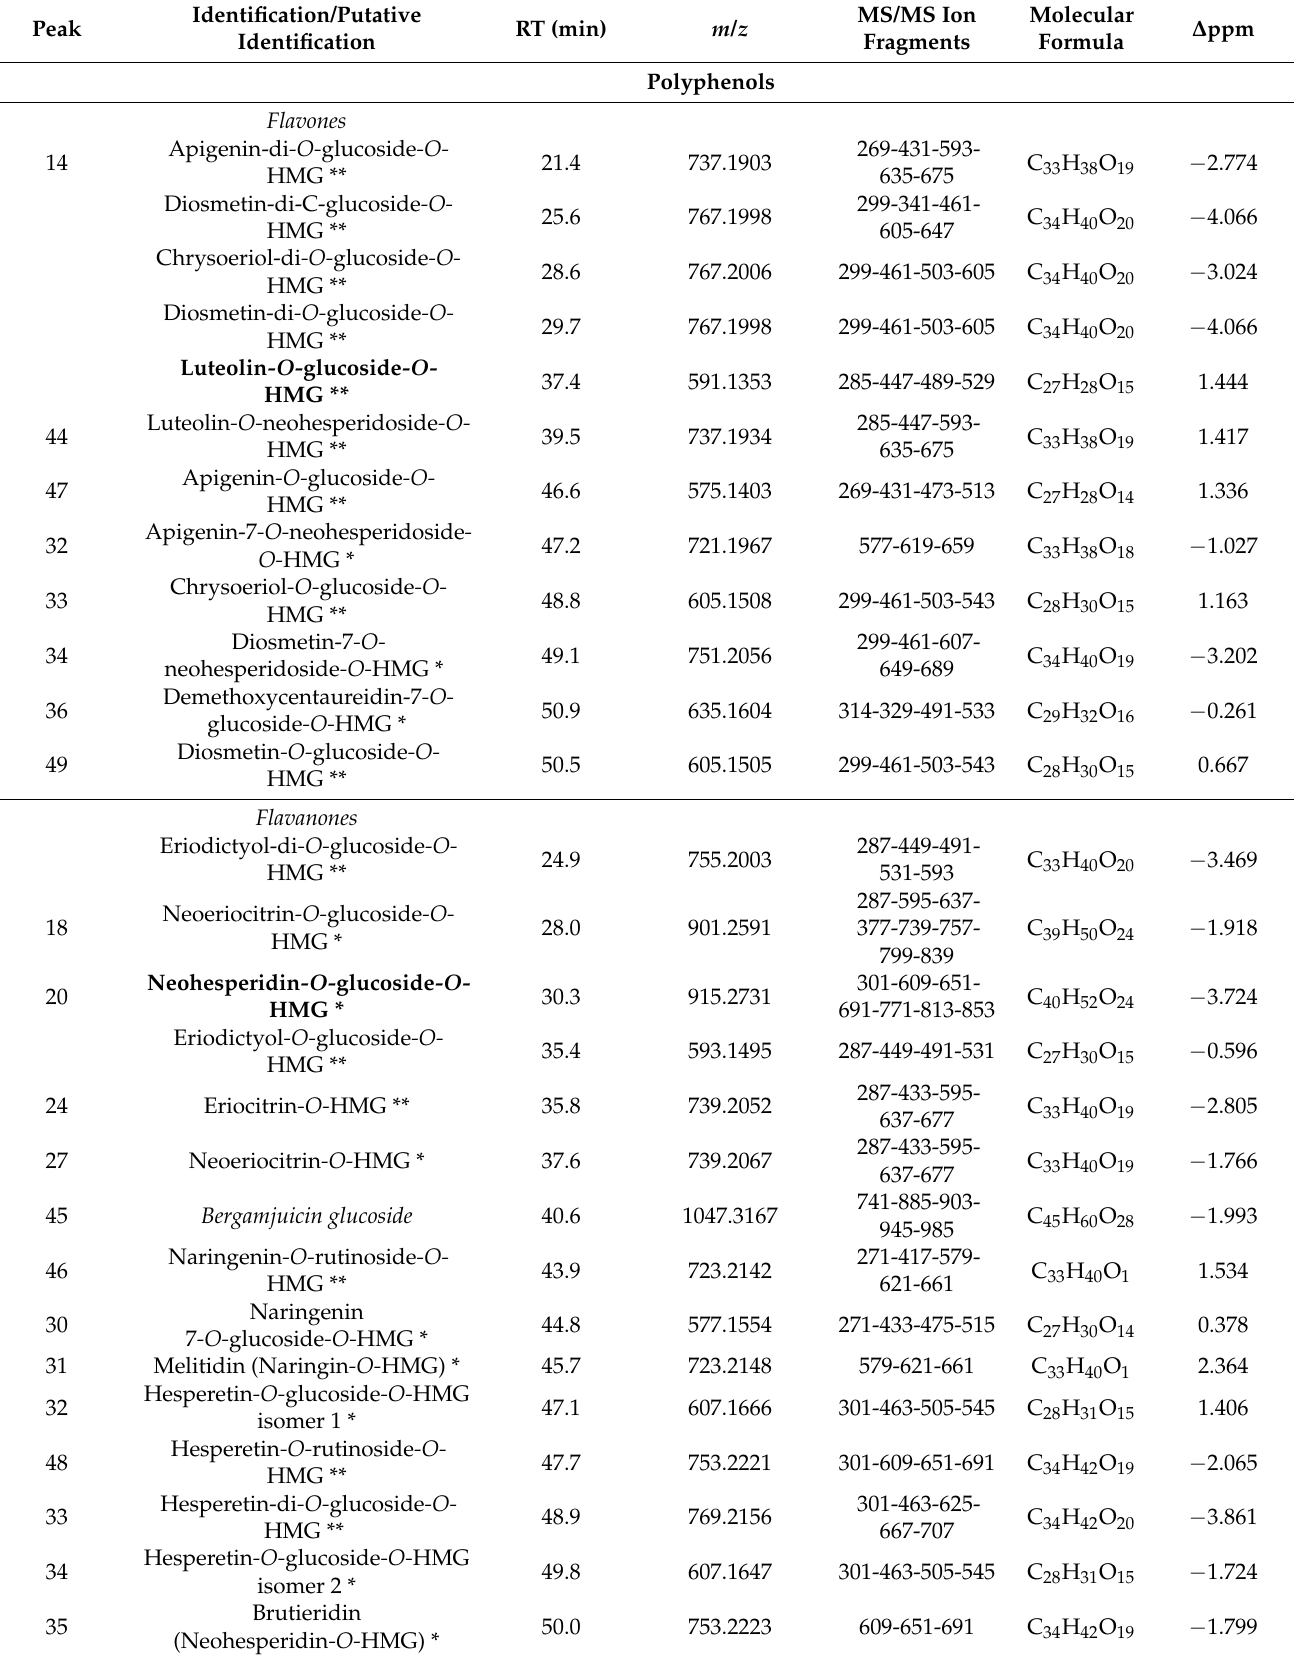
Table 2. Compounds identified * and putatively identified ** with the semi-targeted method divided for flavonoid classes. In bold the compounds only present in BLPF, in italics those only present in